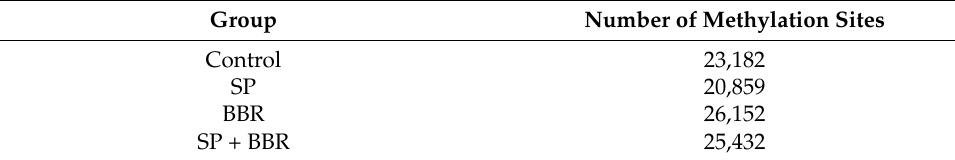
Table 3. Number of methylation sites. Group Number of Methylation